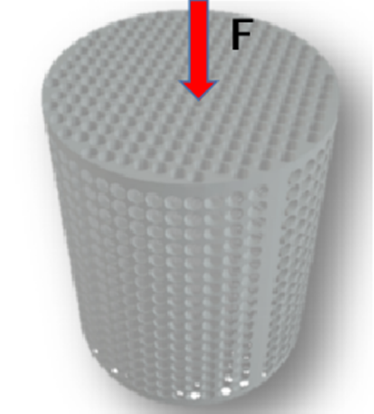
Figure 5. The force model of porous structure in finite element compression simulation. (red arrow is direction of force and F is force).